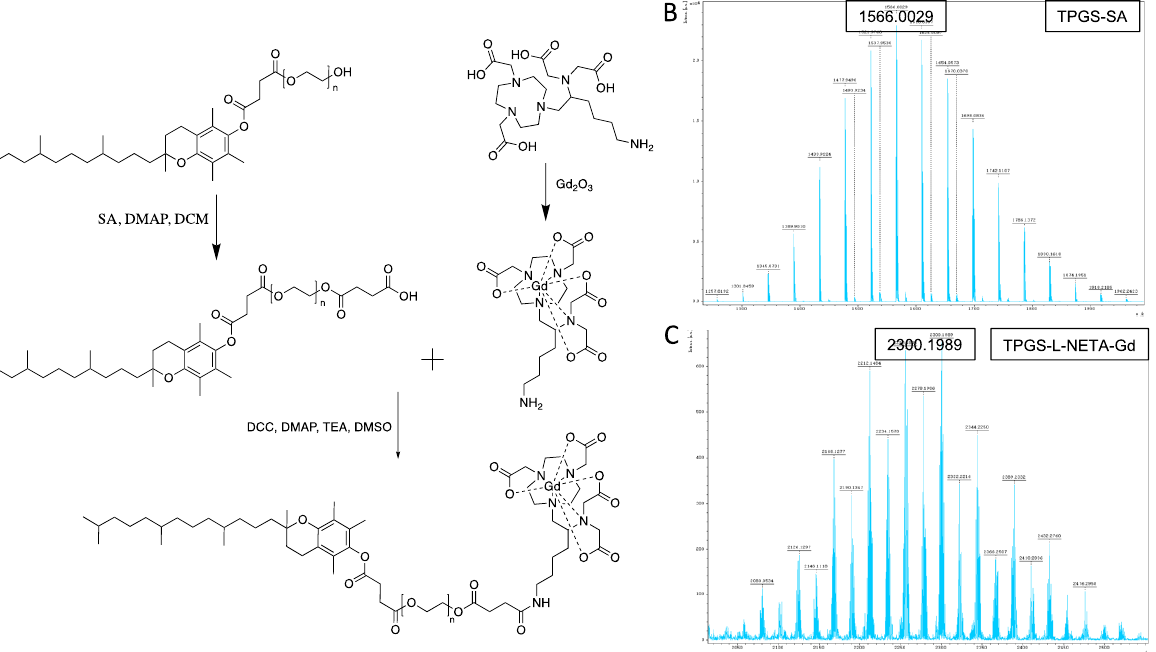
Figure 2. ( A ) Synthesis of L-NETA-Gd and TPGS-L-NETA-Gd (T-L-Gd); ( B ) mass spectrum of TPGS-SA; ( C ) mass spectrum of